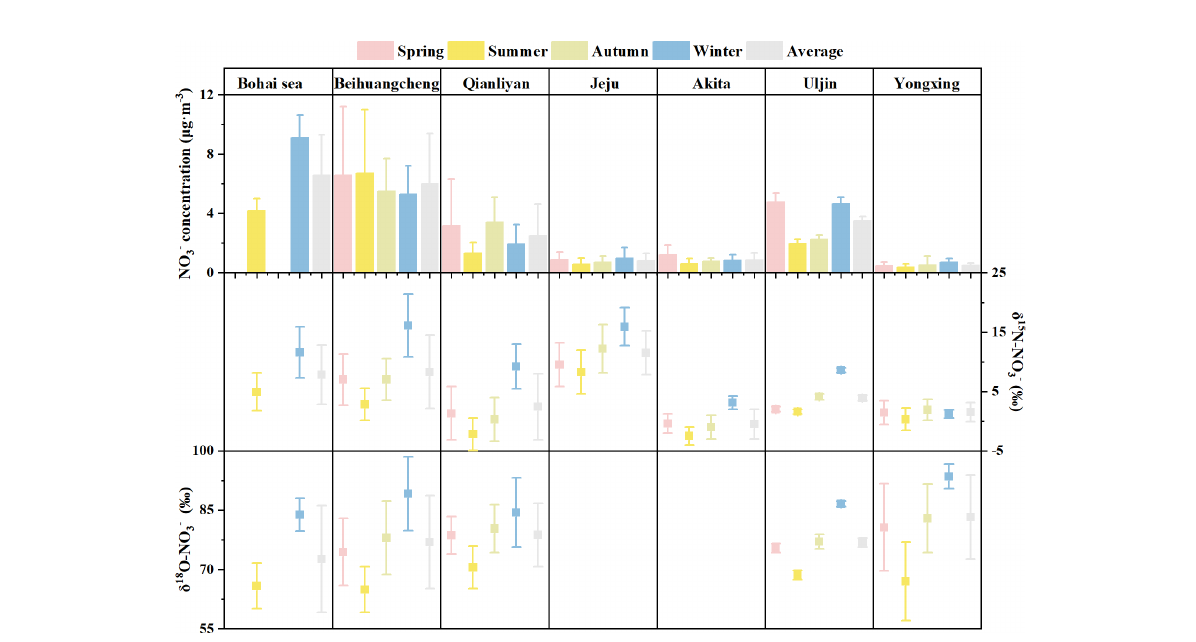
FIGURE 5 The seasonal and annual average ( ± SD) of nitrate concentrations ( m g·m − 3 ) and nitrogen and oxygen isotopic compositions ( ‰ ) of nitrate over the marginal seas of China and the East/Japan sea. Data source: the Bohai Sea (Zong et al., 2022), Beihuangcheng (Zong et al., 2017), Jeju (Kundu et al., 2010), Akita (Kawashima, 2019), Uljin (Kim et al., 2019), and Yongxing (Xiao et al.,